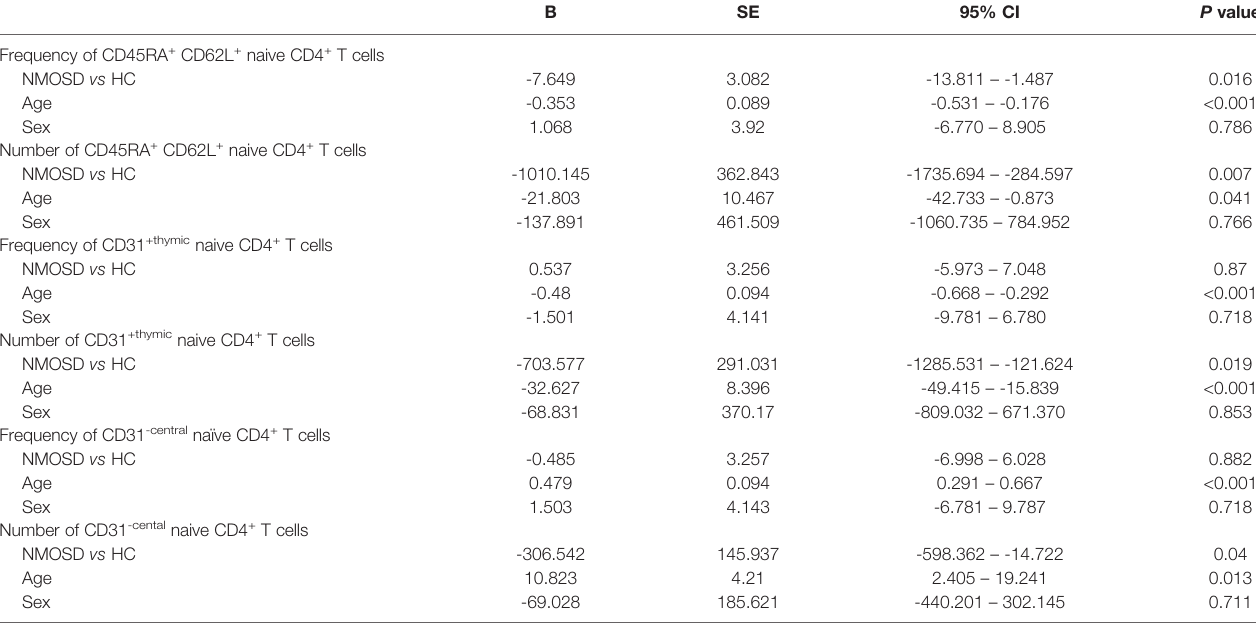
TABLE 2 | Linear regressions analysis between multiple variables and naïve T cells.